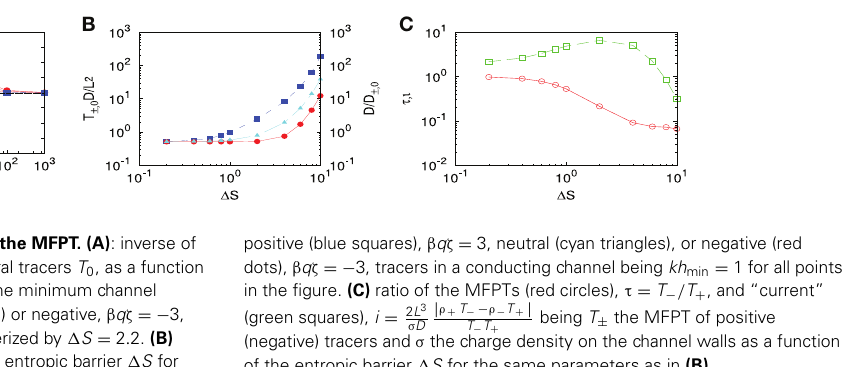
FIGURE 3 | Influence of the entropic barrier on the MFPT. (A) : inverse of the MFPT, 1 / T ± , normalized by the MFPT of neutral tracers T 0 , as a function of the inverse Debye length, k − 1 , normalized by the minimum channel amplitude h min for positive, β q ζ = 3, (blue squares) or negative, β q ζ = − 3, (red dots) tracers in a conducting channel characterized by (cid:3) S = 2 . 2. (B) MFPT, T , normalized by L 2 / D , as a function of the entropic barrier (cid:3) S for